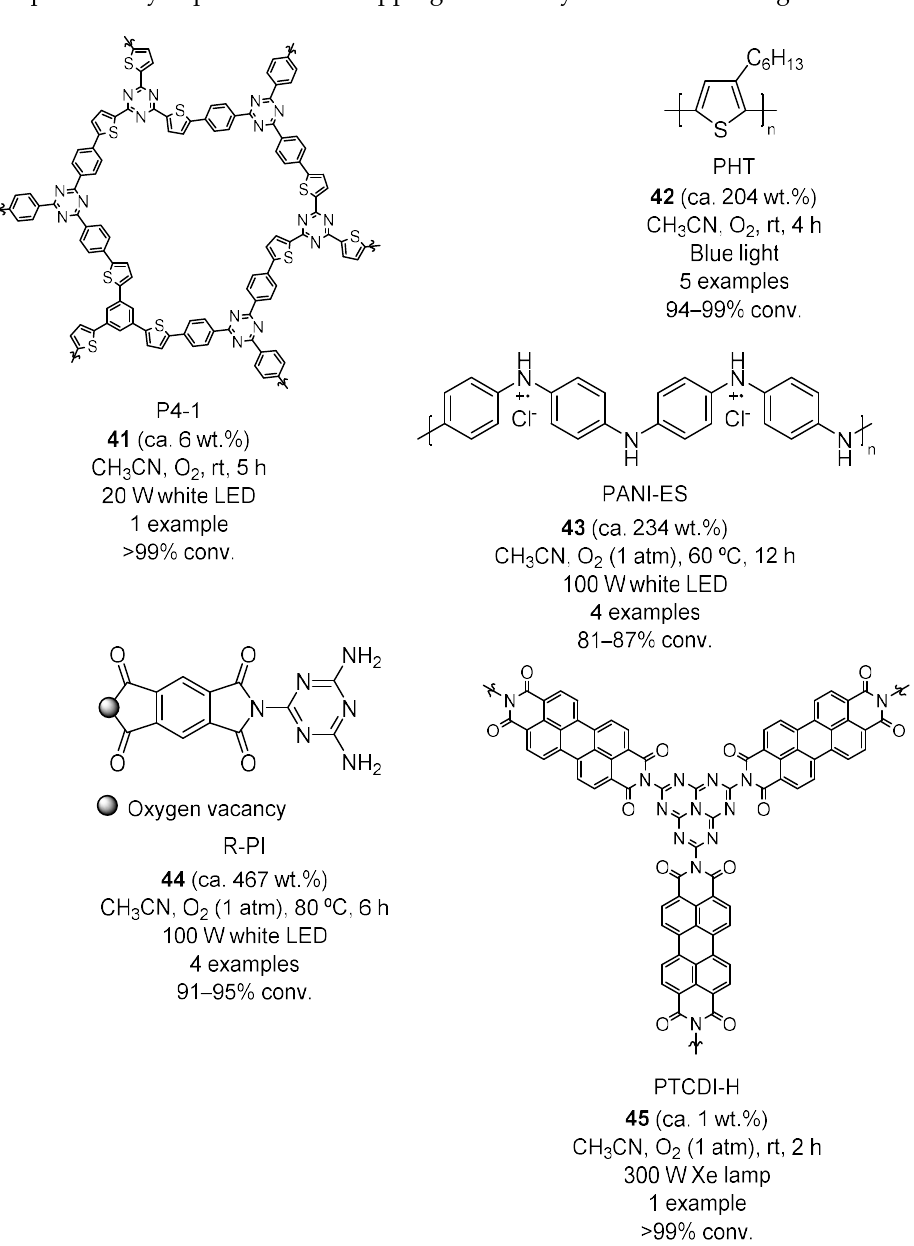
Figure 7. Results obtained in the aerobic photo-oxidative coupling of benzylamines to N -benzylidene benzylamines 2 catalyzed by 41 – 45 .